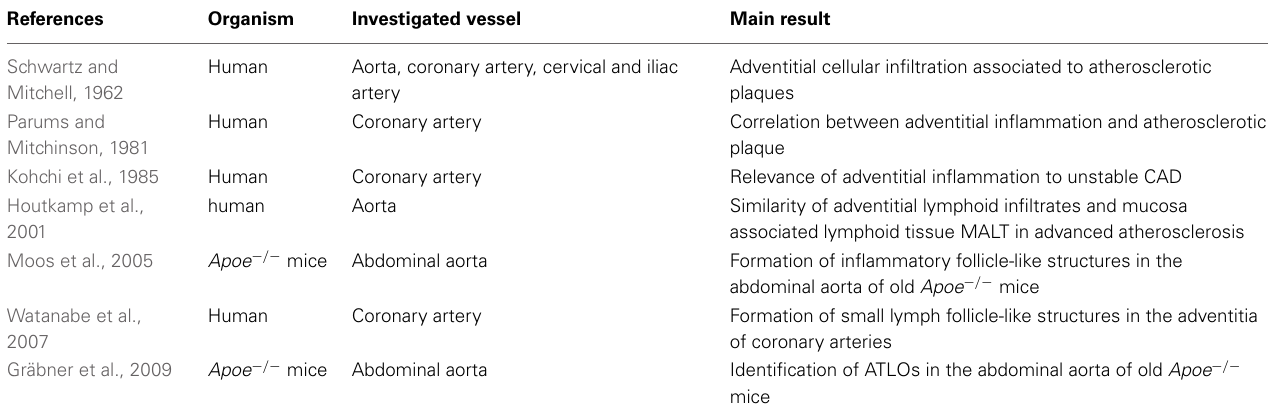
Table 1 | Adventitial inflammation in relation to